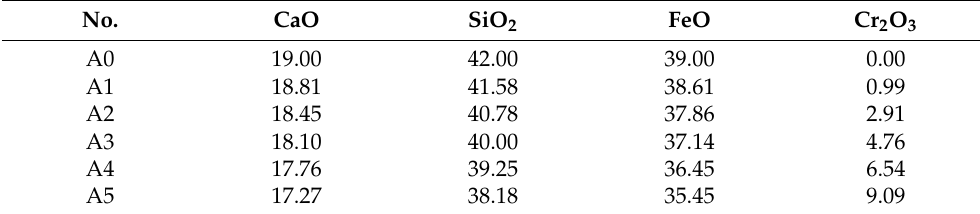
Table 1. Chemical composition of slag,